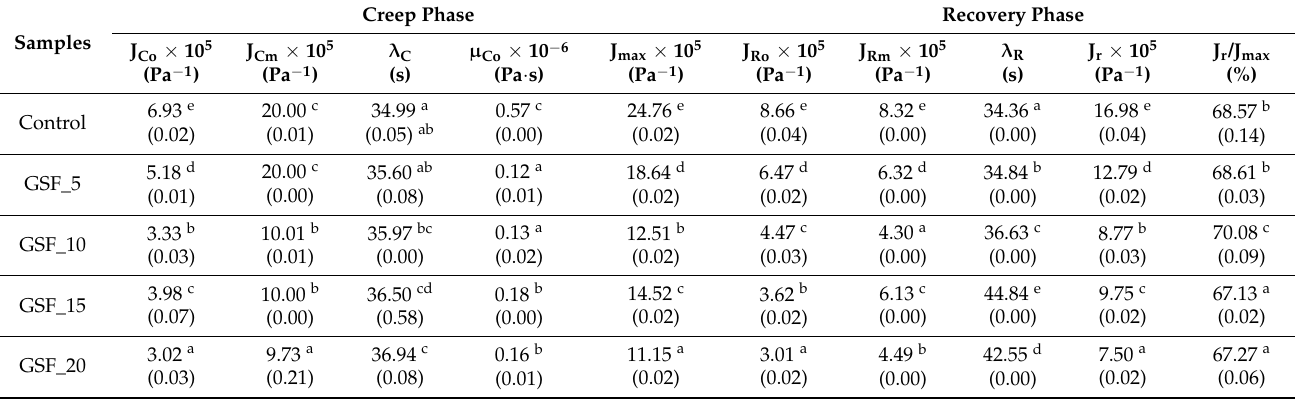
Table 2. Parameters of Burger (cid:48) s